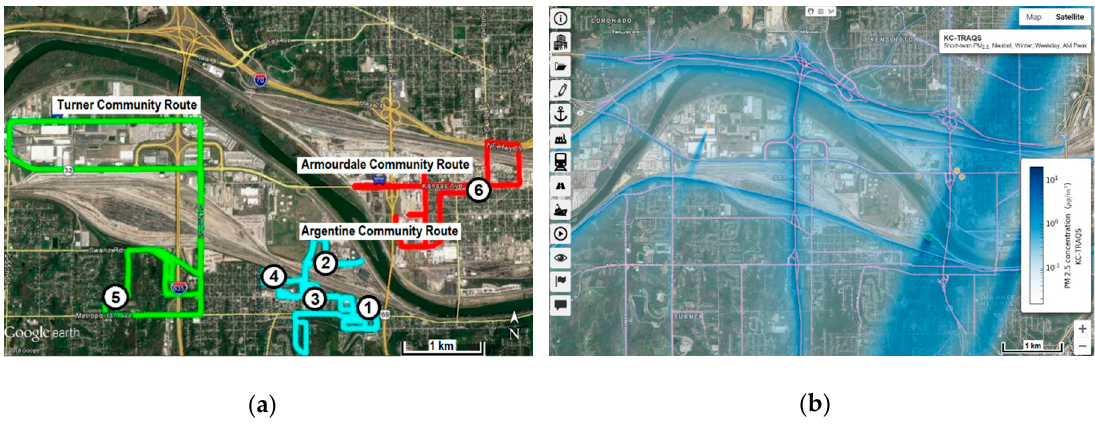
Figure 1. Locations of stationary and mobile measurements ( a ) and a screen shot of C-PORT model simulations of primary PM 2.5 impacts ( b ) for selected meteorological conditions (winter, neutral stability, NNE winds).